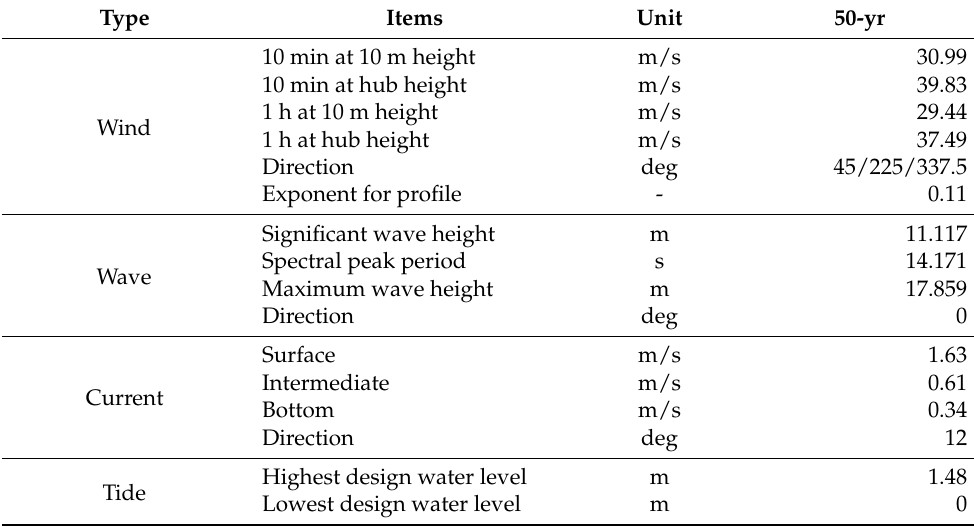
Figure 5. Wind rose with different wind speeds. Table 5. Extreme environmental design Table 5. Extreme environmental design condition.